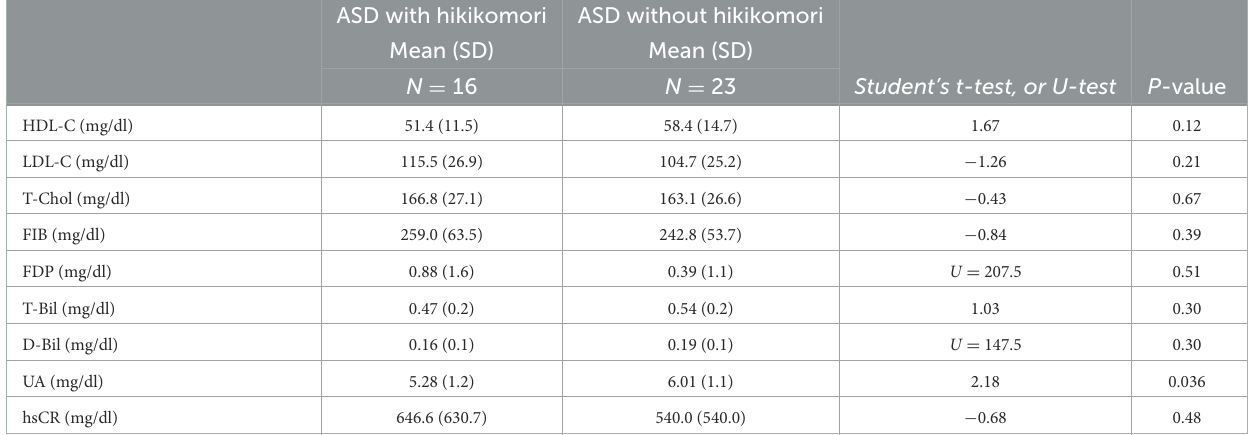
non-fasting venous blood, effects of meal on serum LDL-C and HDL-C were thought to be